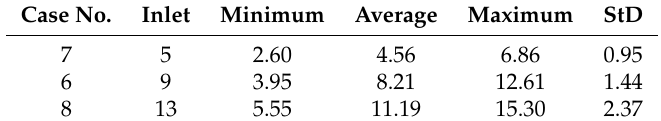
Table 5. Nacelle wind speed with variable averaged inlet wind speed (m/s).